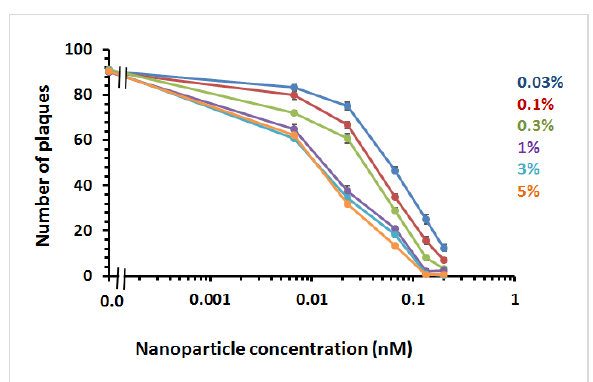
Figure 7: Determination of the half maximal inhibitory concentration (IC 50 ) of silver nanoparticles functionalised with FluPep ligand. Inhibi- tion of plaque formation as a function of the concentration of silver nanoparticles functionalised with different molar fractions of FluPep ligand. Results are the mean ± SD ( n = 3).